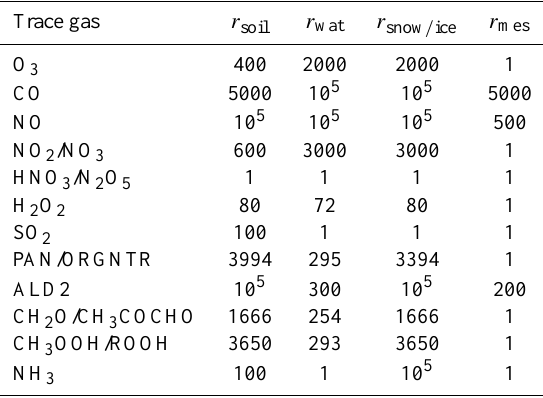
Table 7. Applied emission totals. References: [1] RETRO (Schultz et al., 2007); [2] REAS (Ohara et al., 2006); [3] ORCHIDEE (Lathi`ere et al., 2006); [4] GEIA (Guenther et al. 2005); [5]